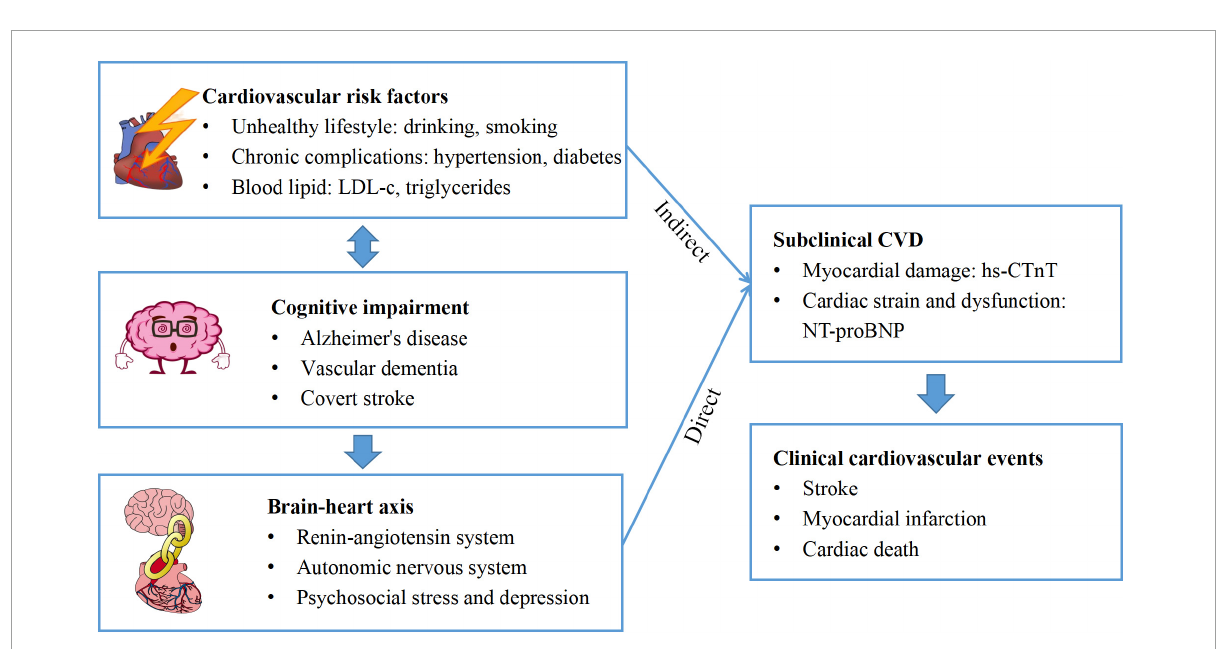
FIGURE3 Possible mechanisms of cognitive impairment and subclinical cardiovascular disease (CVD).